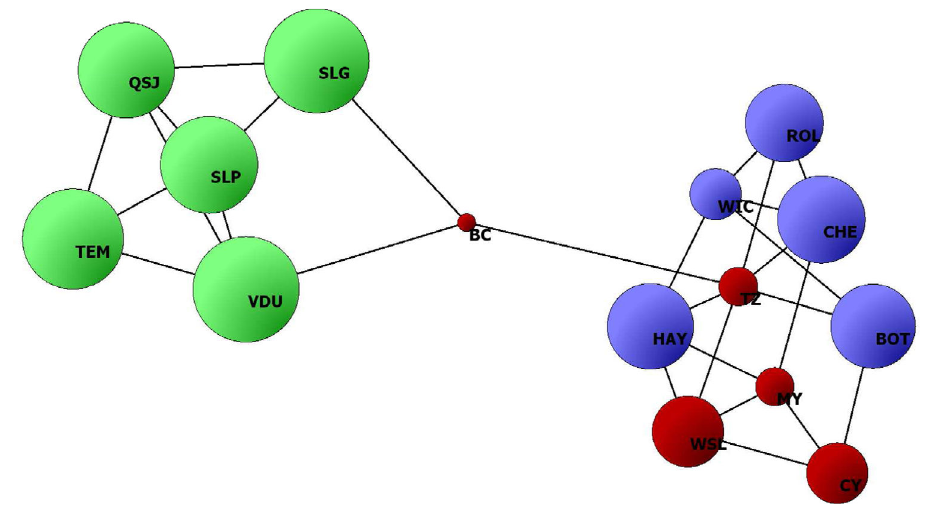
Figure 5. Network diagram of 15 populations of Solanum rostratum in Mexico (green circles), the U.S.A. (blue circles), and China (red circles) calculated in POPULATION GRAPH [32]. The diameter of each sphere is proportional to the amount of heterozygosity in each population. Black lines represent connections (edges) linking two populations.